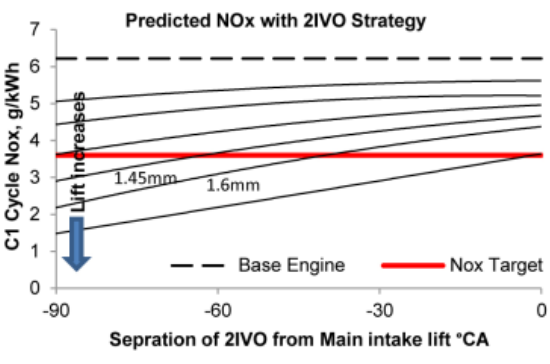
Fig. 12 Predicted NO X with 2IVO strategy